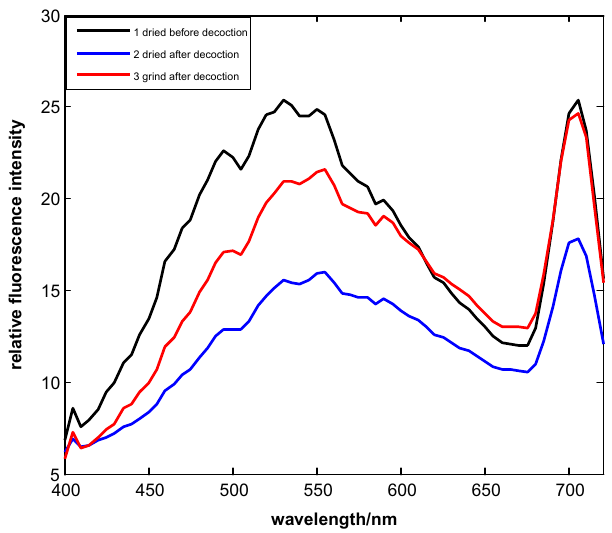
Fig. 3. The characteristic spectra of the sample before and after decoction. The black curve is the spectrum of the original sample, the blue curve is the spectrum of the sample after decocting and drying, and the red curve is the spectrum of the sample powder after decocting, drying and